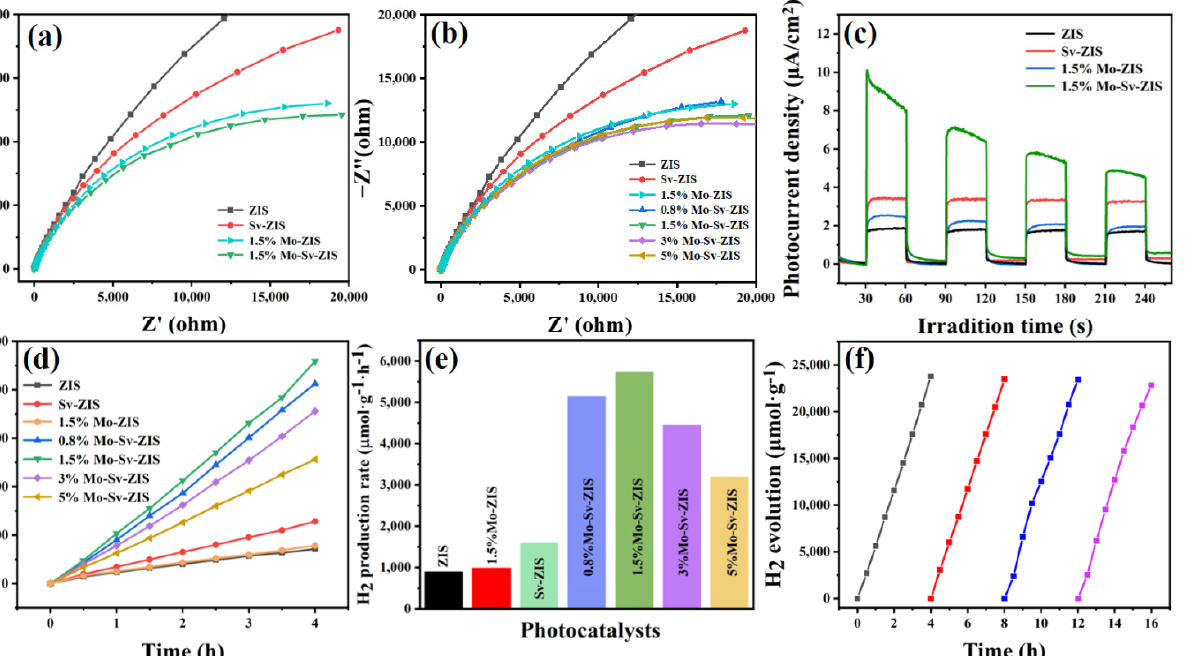
Table S6, photocatalytic hydrogen evolution activities over 1.5% Mo-Sv-ZIS